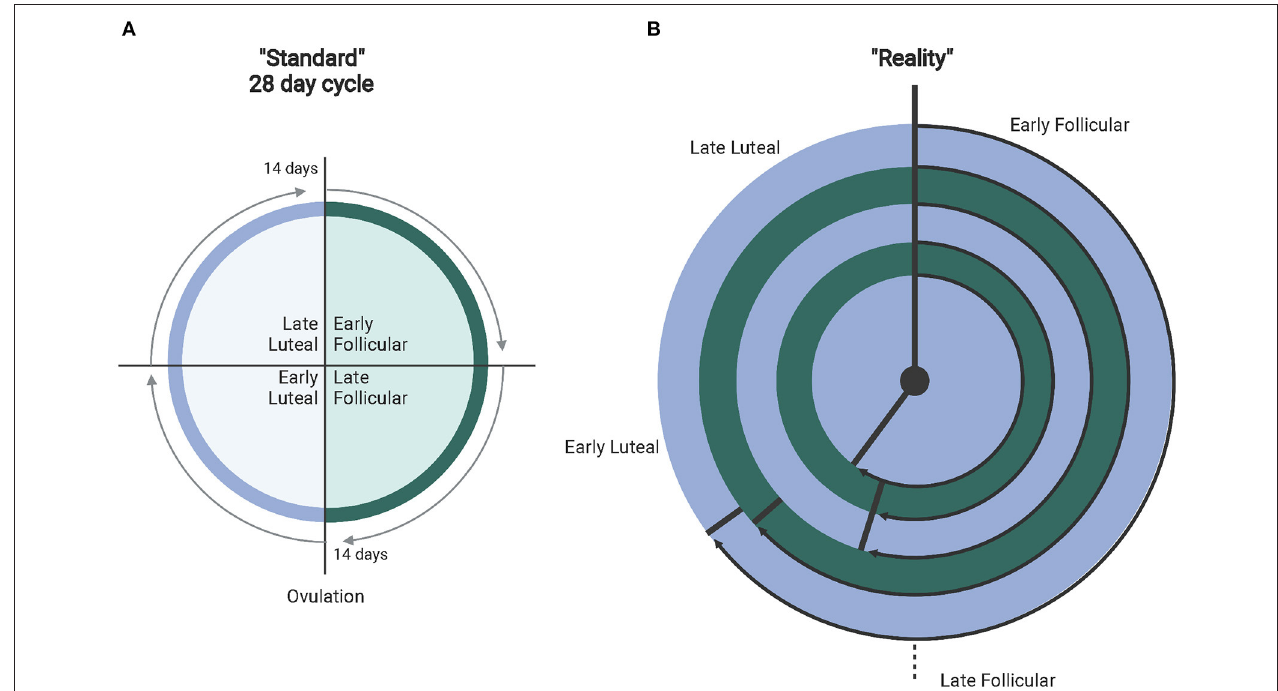
FIGURE 1 | (A) Depicts the standardly accepted 28-day menstrual cycle. (B) The different ranges of real-world normal cycles (experiencing proper hormone fluctuations). From outer to inner ring: 36–50 days (avg. 40 depicted) with ovulation at 26.8 days (67% follicular). 31–35 days (avg. 32 days)–ovulation at 19.5 days (61% follicular). 25–30 days (avg. 28 days follicular) with ovulation at 15.2 days (54% follicular). 21–24 days (avg. 23 days) with ovulation at 12.4 days (54% follicular). Finally, 15–20 days (avg. 18 days) with ovulation at 10.4 days (57% follicular). Created with